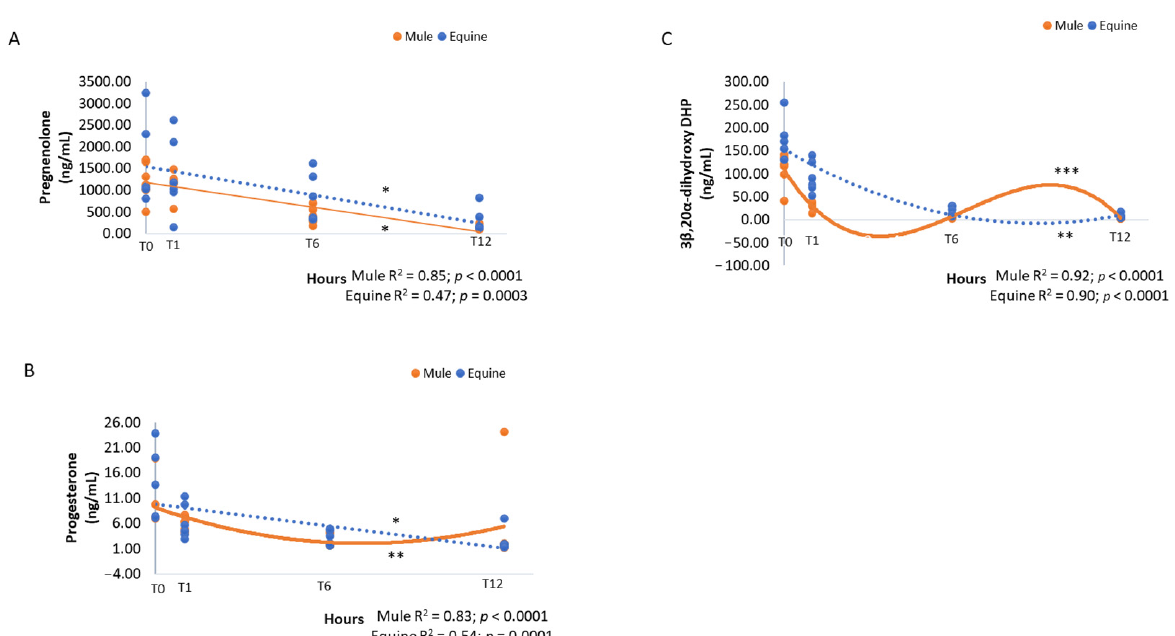
Figure 2. Pregnane concentrations of pregnenolone ( A ), progesterone ( B ) and 3 β ,20 α -dihydroxy DHP ( C ) (ng/mL) in neonatal mule (n = 6, solid lines) and equine (n = 6, dashed lines) foals at birth (immediately after expulsion–T0), and at 1 (T1), 6 (T6) and 12 h after birth (T12). Results represent the mean. * Linear, ** quadratic and *** cubic effects are shown with R 2 and p -values. The disappearance with time of pregnenolone, progesterone, and 3 β ,20 α -DHP con- trasted with sustained corticosterone (averaging 4–5 ng/mL at foaling) and cortisol (av- eraging 40–50 ng/mL) concentrations (Table 2). Corticosterone and cortisol remained unchanged for the first hour post-foaling then declined rapidly to relatively low levels in samples taken at the 6 and 12 h ( p < 0.0001, Table 2). The decline was best described as cubic for mule foals (Figure 3, R 2 = 0.68, p < 0.0001) and linear for equine foals (Figure 3, R 2 = 0.43, p = 0.0006) for corticosterone and cubic for mule foals (Figure 3, R 2 = 0.89, p < 0.0001) and quadratic for equine foals (Figure 3, R 2 = 0.74, p < 0.0001) for